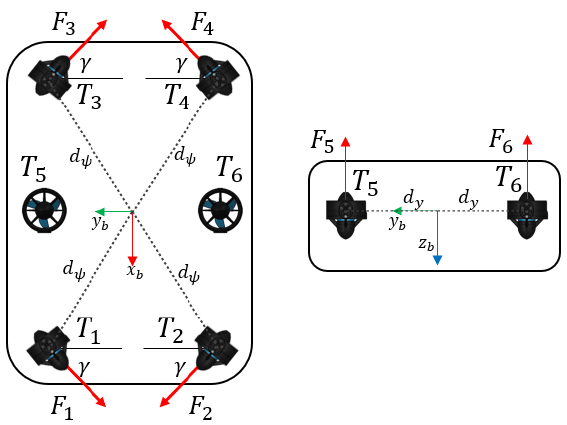
Figure 3. Thruster configuration of the BlueROV2 vehicle. Top view (left). Front view (right). The control signal τ υ can be computed